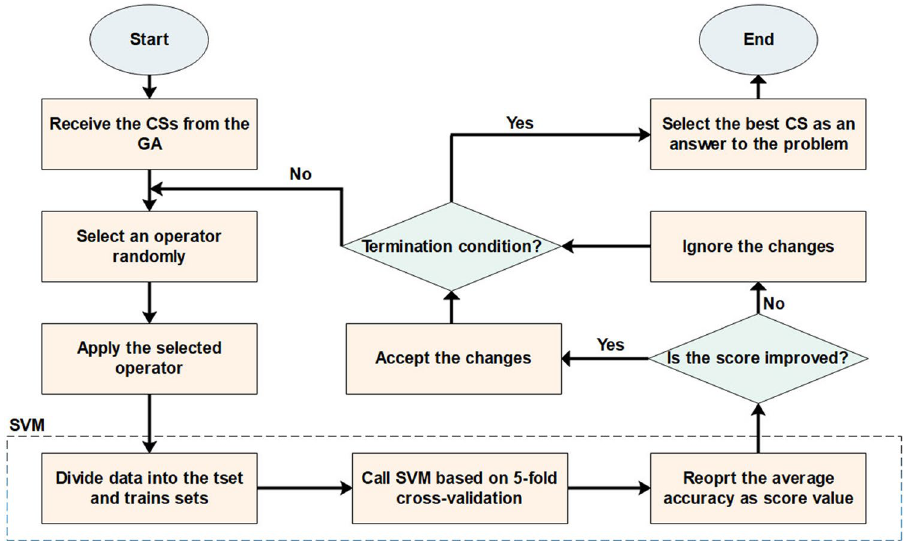
Figure 5. Flowchart of the WCC algorithm (the algorithm developed here). The WCC algorithm receives its first population of CSs from the GA and applies its operators on them. If the changes induced by the operators improve the accuracy, they are accepted. Otherwise, the changes are ignored. CS, candidate solution; GA, genetic algorithm; SVM, support vector machines.